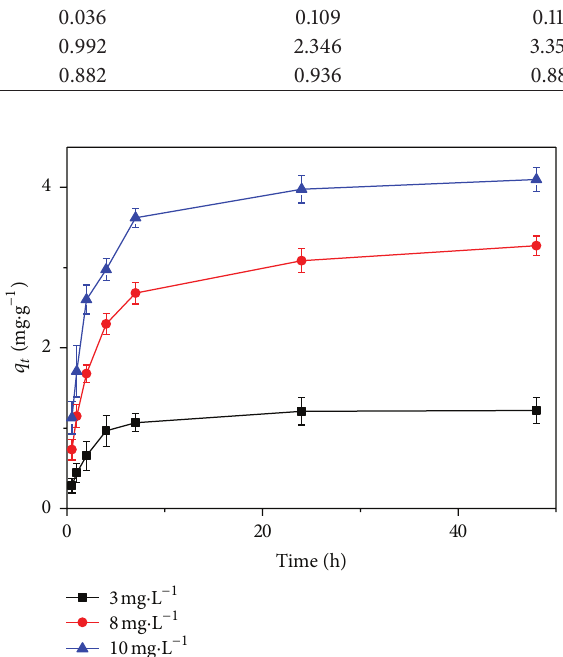
Figure 3: As (III) adsorption capacity onto Ce-Al-Fe trimetal oxide adsorbent for different contact time and initial As (III) concentrations (pH = 7.0, initial As (III) concentration = 3, 8, and 10 mg ⋅ L −1 , the temperature = 25 ± 1 ∘ C, and adsorbent dosage = 2 g ⋅ L −1 ). 𝑘 𝑞 𝑒2 (mg ⋅ g −1 ⋅ h −1 ) can be considered to be the rate as 2